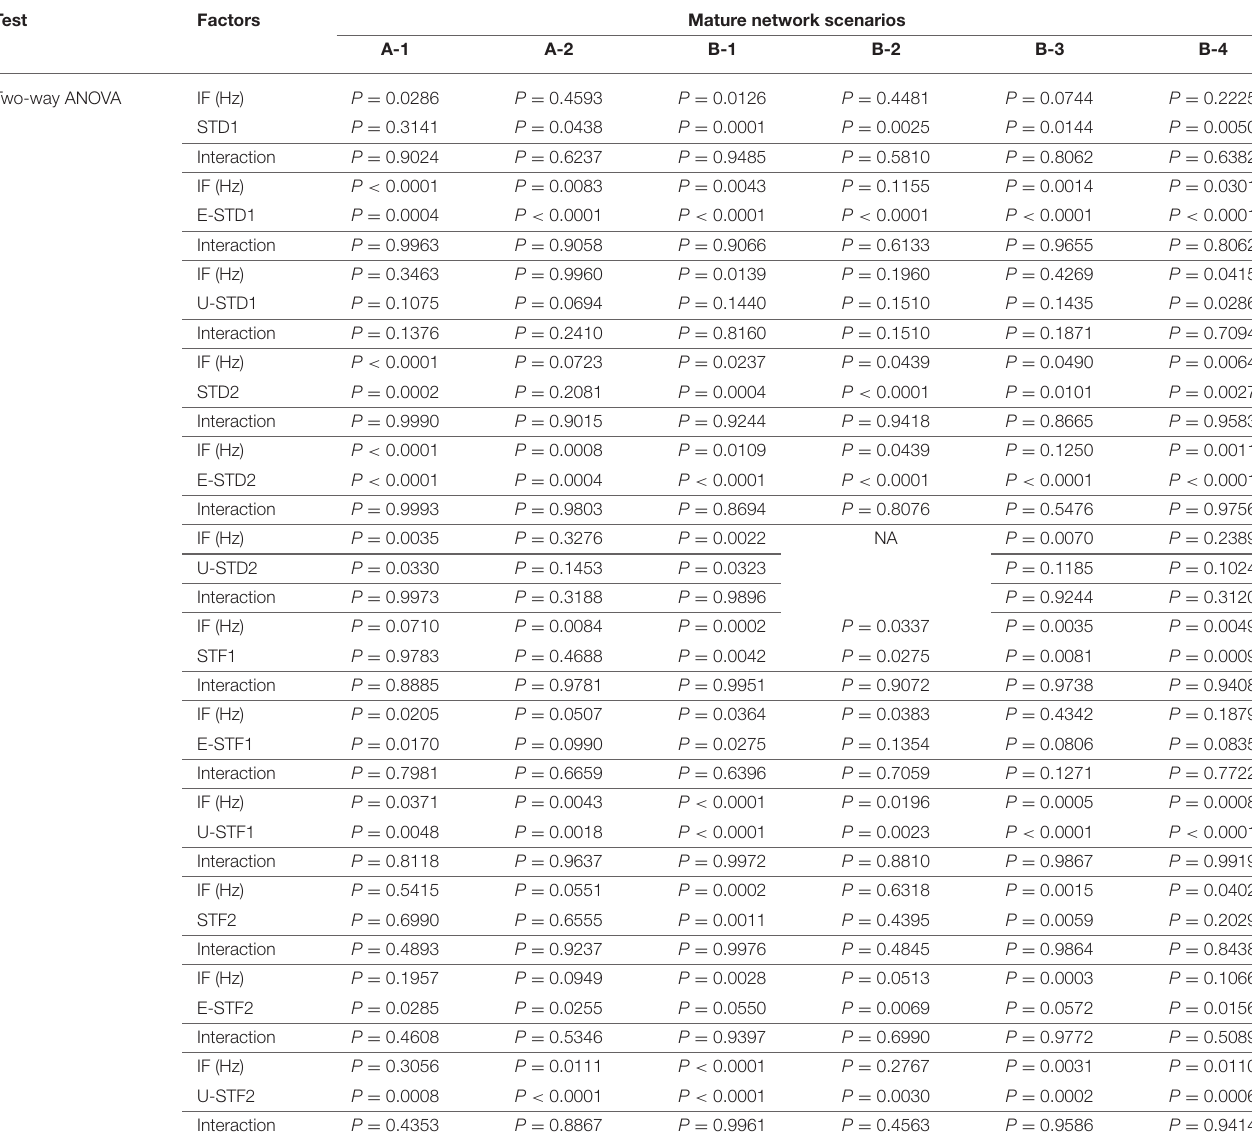
TABLE 6 | Two-way ANOVA for mature network scenarios. Test